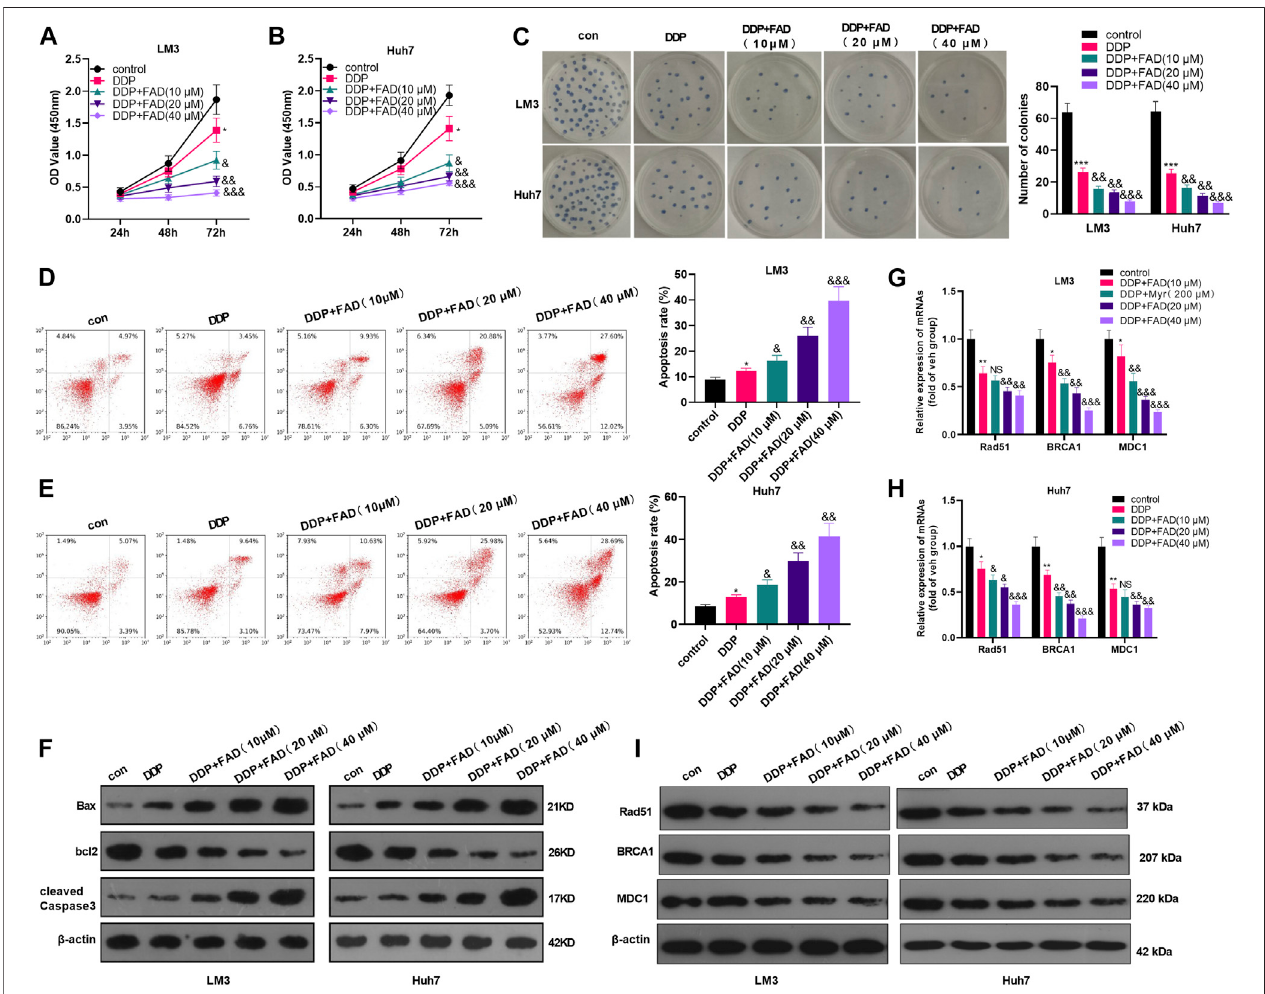
FIGURE 2| FAD enhanced the chemosensitivity ofHCC to DDP.HCC cell lines (Huh7 and LM3) were treated with DDP (2 μ g/mL) for 24 h. On this basis, FAD (10, 20, 40 µM) was applied to deal with the cells for 24 h. (A – C) , Cell proliferation was examined by CCK-8 assay and colony formation assay. (D, E) , Cell apoptosis was determined by FCM. (F) . WB was implemented to verify the expression of the apoptosis-related proteins (including Bax, bcl2, and cleaved Caspase3). G-I. qRT-PCR (G – H) and WB (I) were used fordetecting DNA repair-related genes/proteins (including Rad51, BRCA1, and MDC1) inHuh7 and LM3 treatedwithFAD or for24 h *, **, *** represents p < 0.05, p < 0.01, p < 0.001 (vs. con group), respectively. NS, &, &&, &&& represents p < 0.05, p < 0.01, p < 0.001 (vs. DDP group), respectively. N (cid:2) 3. All experiments were repeated for 3